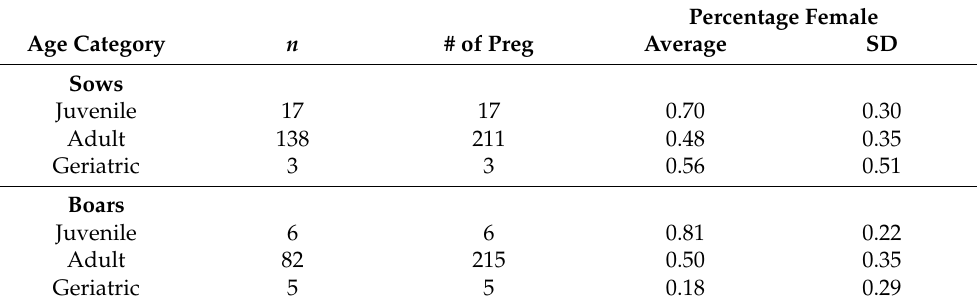
Table 2. Percentage of females in strain 13/N guinea pig litters by sow and boar age at delivery. Litter sex ratio was analyzed for a subset of the total pregnancies listed in Table 1. Both litter sex ratio data and sow age were known for 231 of 266 pregnancies, and litter sex ratio and boar age were known for 226 of 260